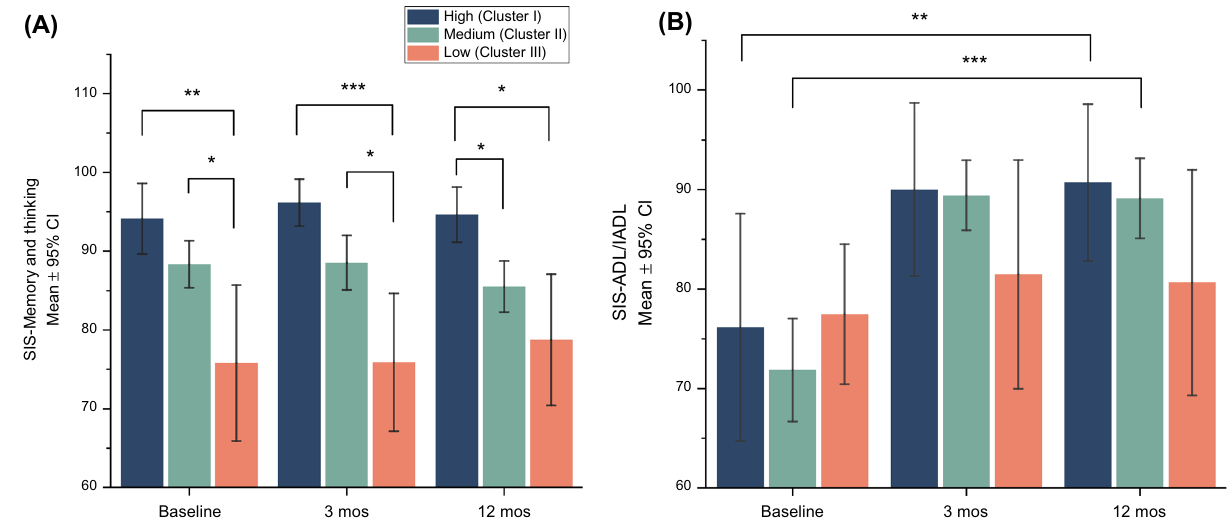
Figure 4. Impact on memory and activities of daily living by different cognitive functioning groups across 3 time points. Data available for SIS-memory and thinking in 93 patients at baseline, 87 patients at 3 and 12 months. Data available for SIS-ADL/IADL in 88 patients at baseline, 87 at 3 and 12 months. *p < 0.05, **p < 0.01, ***p < 0.001. SIS stroke impact scale, CI confidence interval, ADL activities of daily living , IADL instrumental activities of daily